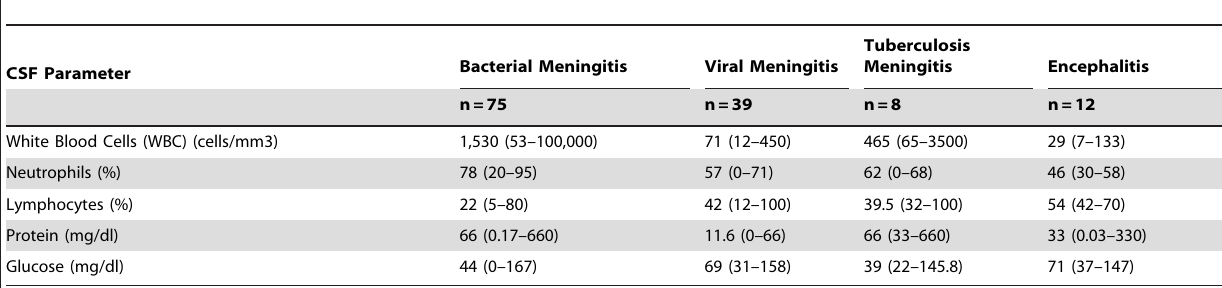
Table 3. Median Values and Ranges of Cereprospinal Fluid (CSF) Parameters among patients with clinically diagnosed central nervous system infections, country of